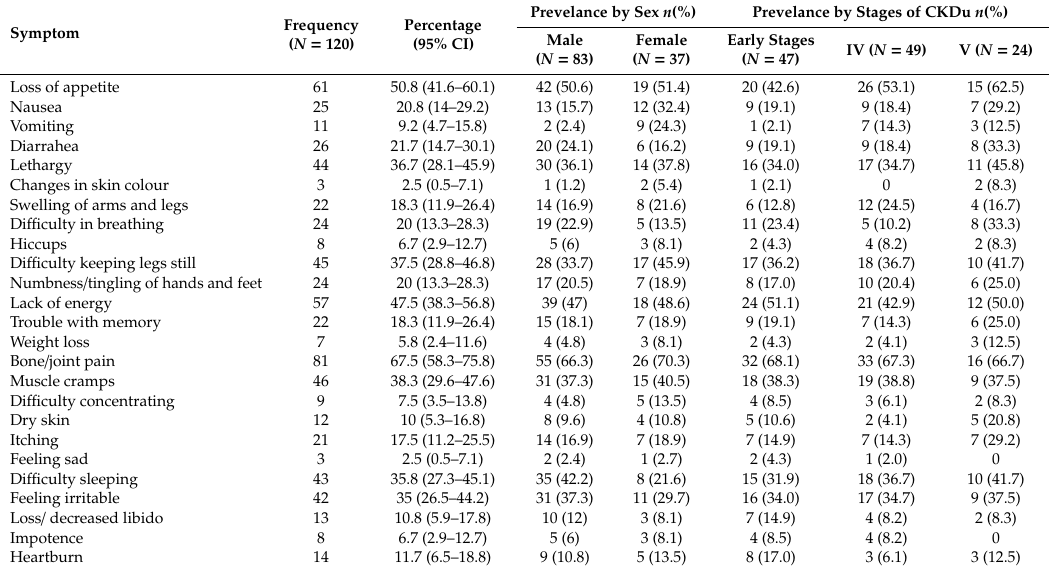
Table 2. Prevalence of symptoms among the study population and prevalence by sex and stage in the disease.